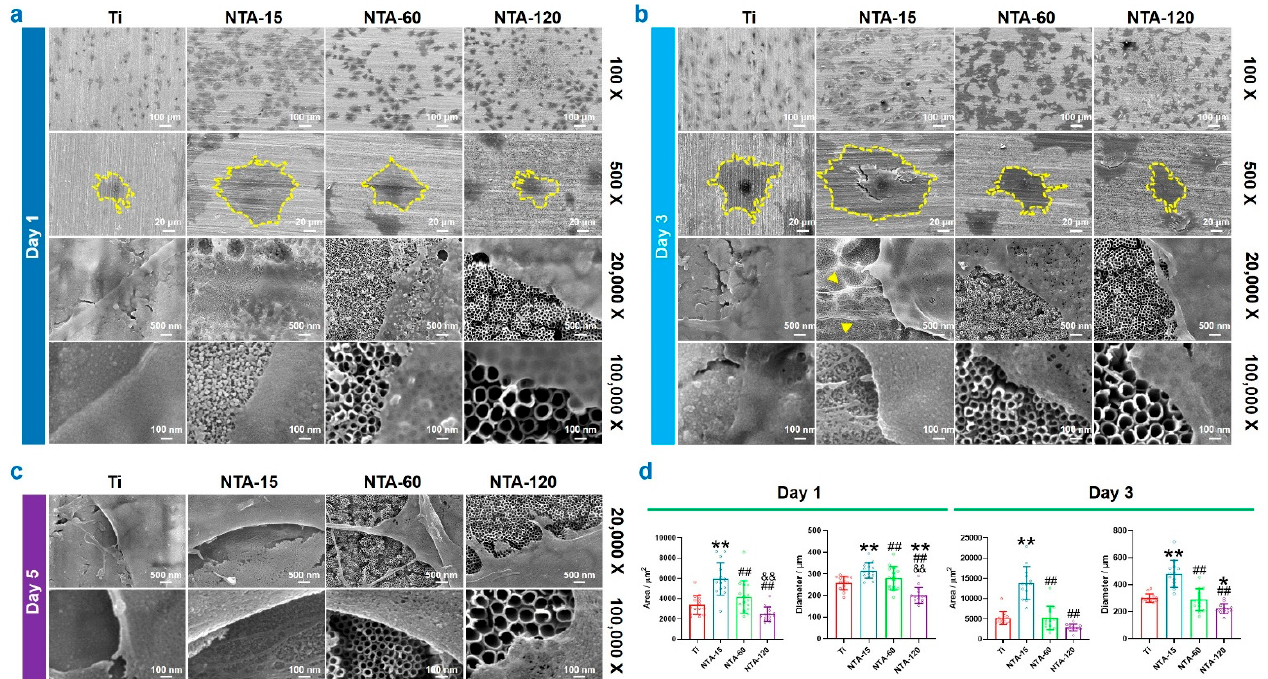
Figure 2. Osteocyte morphology on Ti and NTAs. ( a – c ) Representative images of osteocyte cultured on each group for 1, 3 and 5 days, respectively. ( d ) Qualitative results of single cell spreading area after cultured on each group for 1 and 3 days. * p < 0.05 compared with Ti, ** p < 0.01 compared with Ti, ## p < 0.01 compared with NTA-15, && p < 0.01 compared with NTA-60.